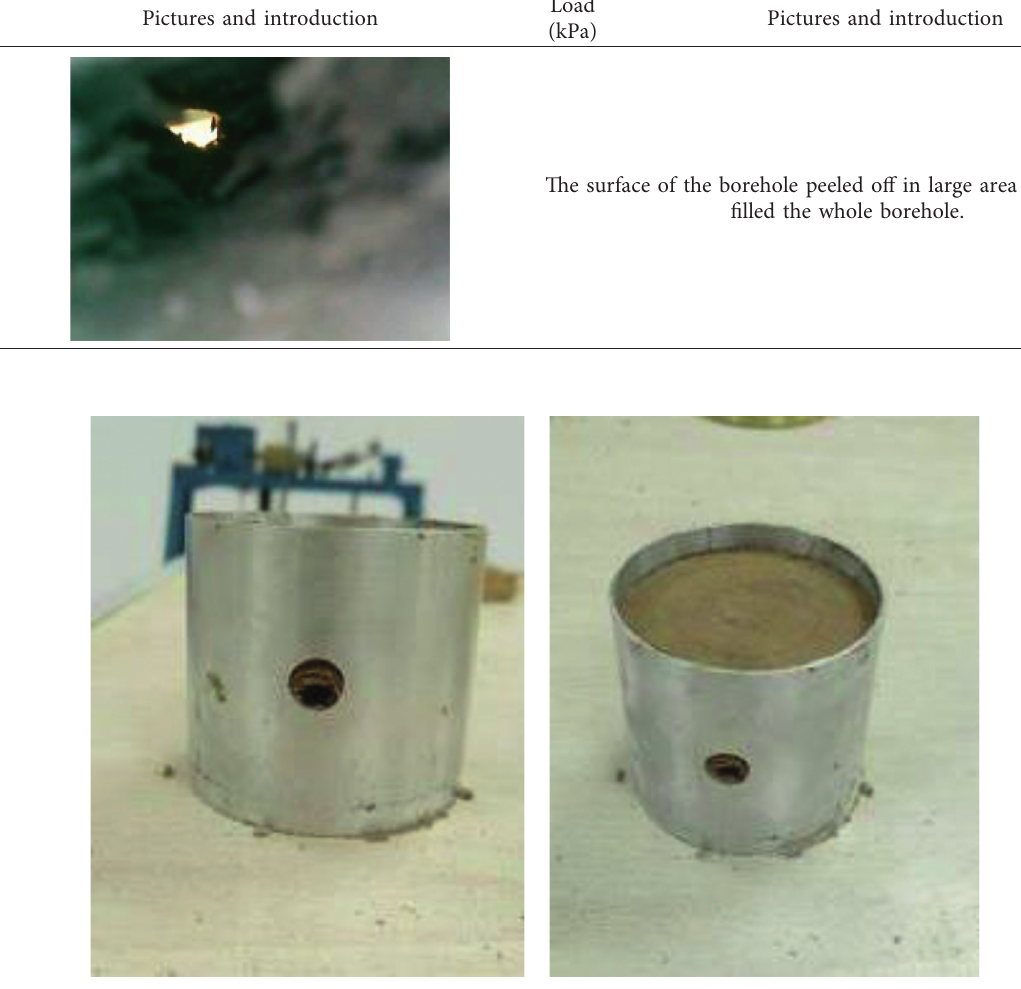
Figure 4: Deformation pattern of the sample after unloading. (a) The form of hole sinking. (b) The overall sinking pattern of the sample.